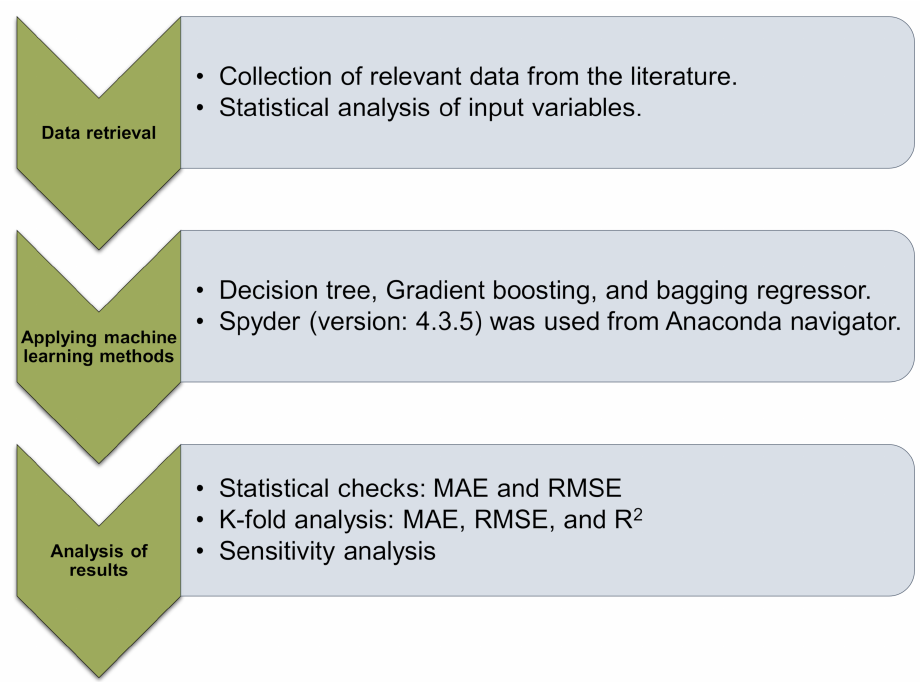
Figure 2. Sequence of research methods.